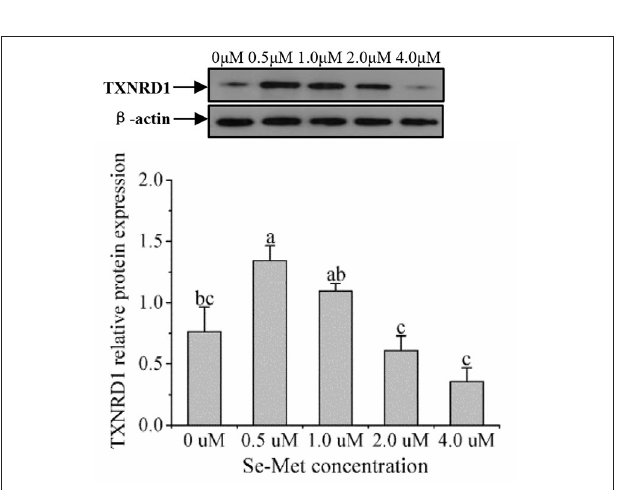
FIGURE 5 | Effects of selenomethionine (Se-Met) supplementation on SELENOP protein expression in porcine mammary epithelial cells (pMECs). The cells were incubated for 48h with different concentrations of Se-Met (0, 0.5, 1, 2, and 4 µ M) and then collected for determination of protein expression. The data are expressed as the mean ± SEM ( n = 3). The β -actin blot was reused as shown in Figure 4 . Different superscript letters indicate a significant difference ( p < 0.05).